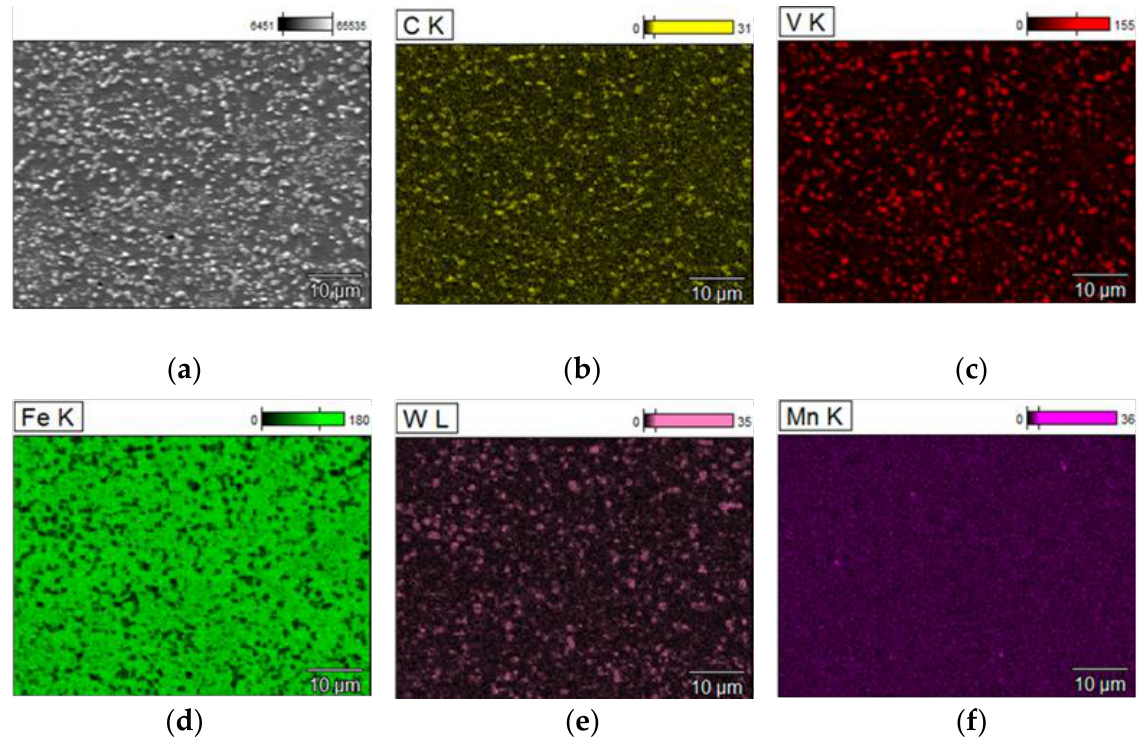
Figure 11. SEM and corresponding EDS mapping micrographs of spark plasma sintered T15 material, ( a ) microstructure, ( b ) carbon, ( c ) vanadium, ( d ) iron, ( e ) tungsten, ( f ) manganese.